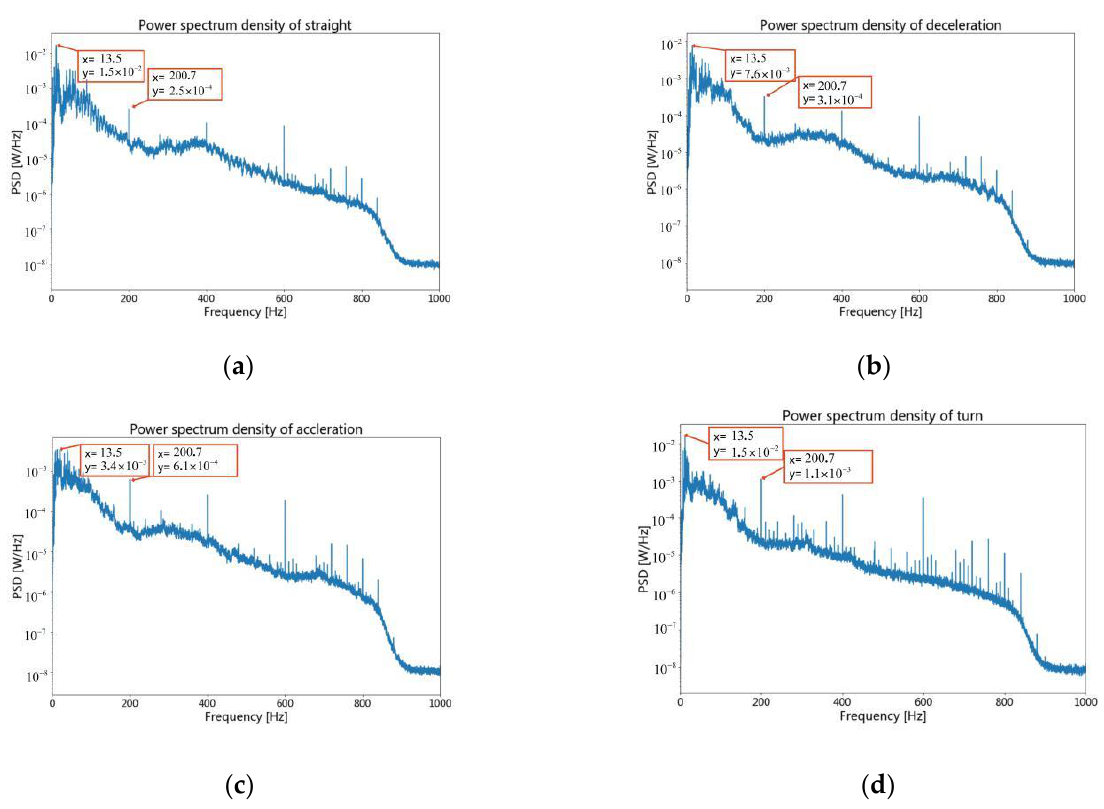
Figure 5. The power spectrum density by the fourth type of vessel. ( a ) The power spectrum density of straight motion. ( b ) The power spectrum density of decelerating motion. ( c ) The power spectrum density of accelerating motion. ( d )The power spectrum density of turning movement.